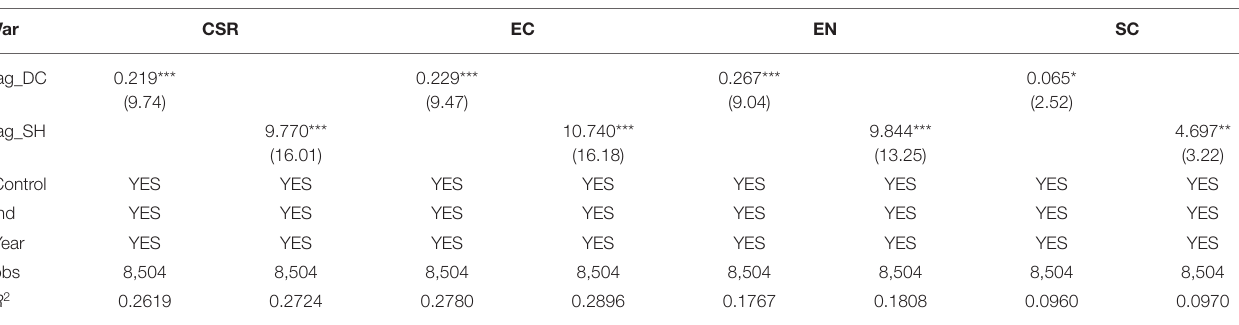
TABLE 4 | Results of